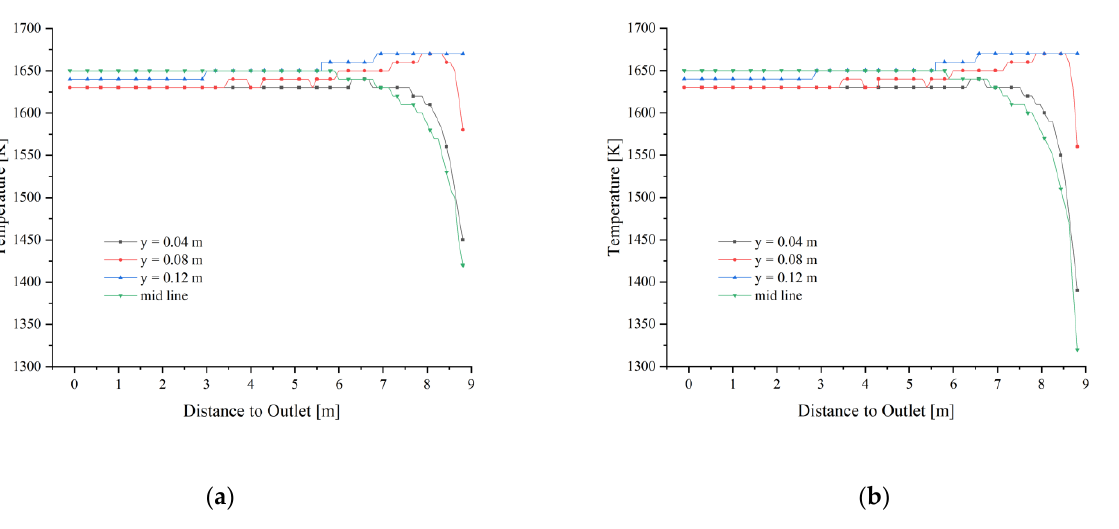
Figure 9. Solid temperature at 40 mm and 80 mm. ( a ) Solid temperature of 40 mm; ( b ) Solid temperature of 80